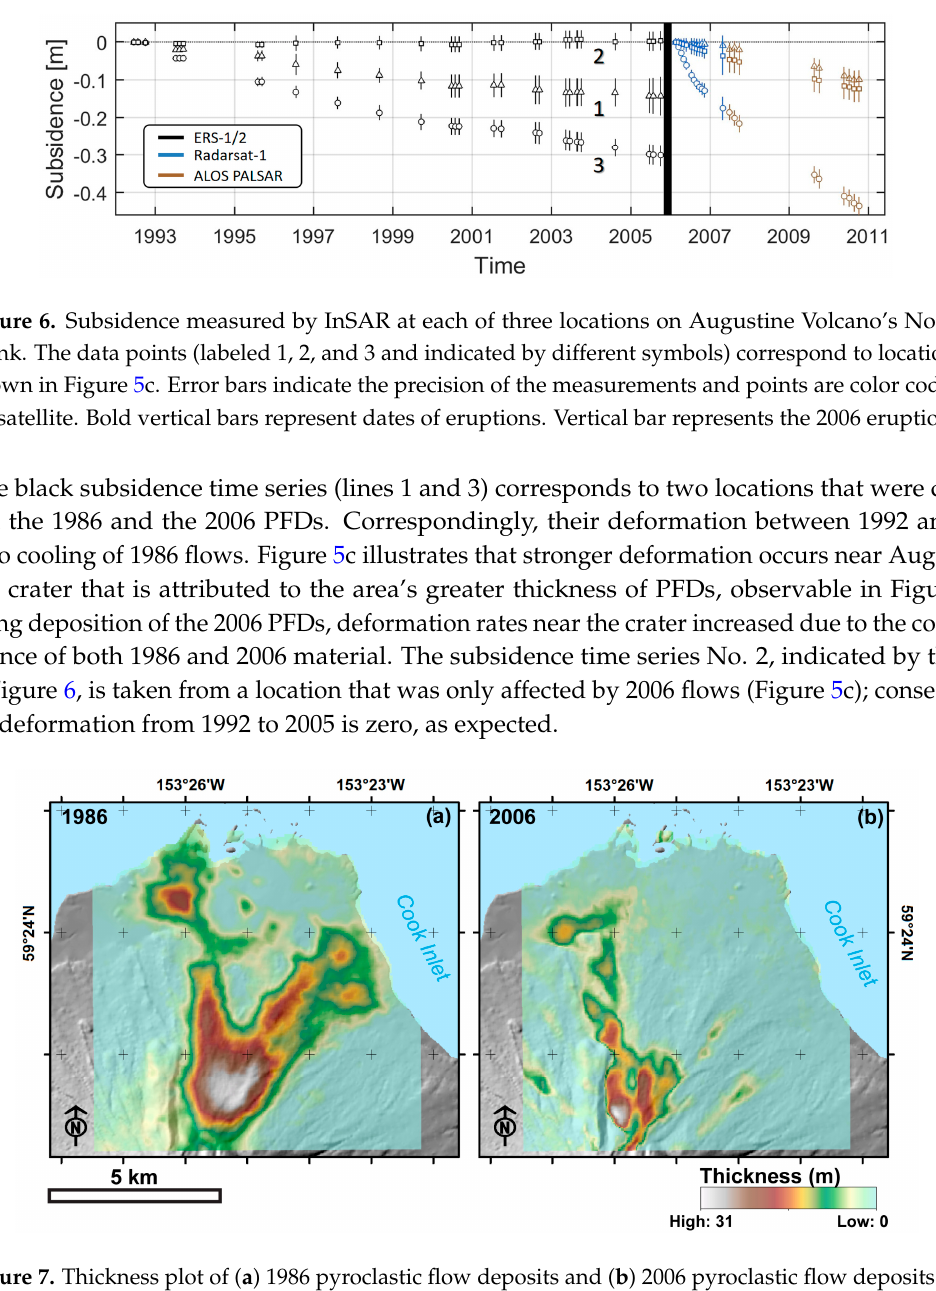
Figure 7. Thickness plot of ( a ) 1986 pyroclastic flow deposits and ( b ) 2006 pyroclastic flow deposits on Augustine Volcano’s north flank. Maximum deposits reach a thickness of ~31m (in white) near the summit crater.